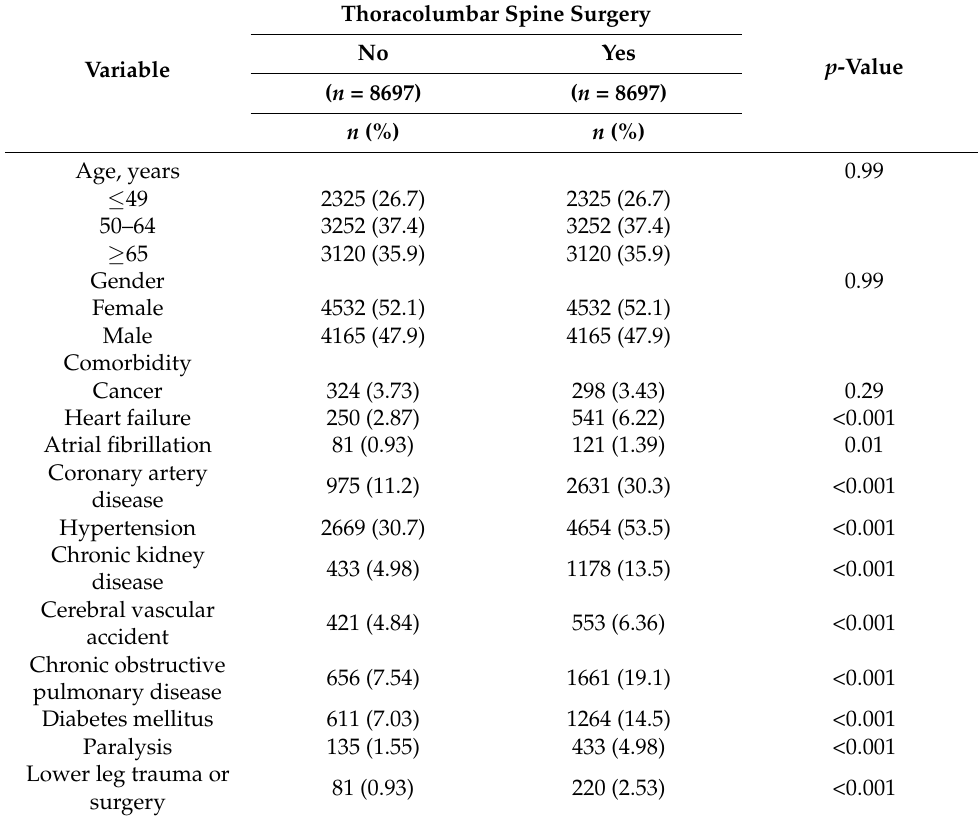
Table 1. Comparison of demographics and comorbidity between thoracolumbar spine surgery patients and